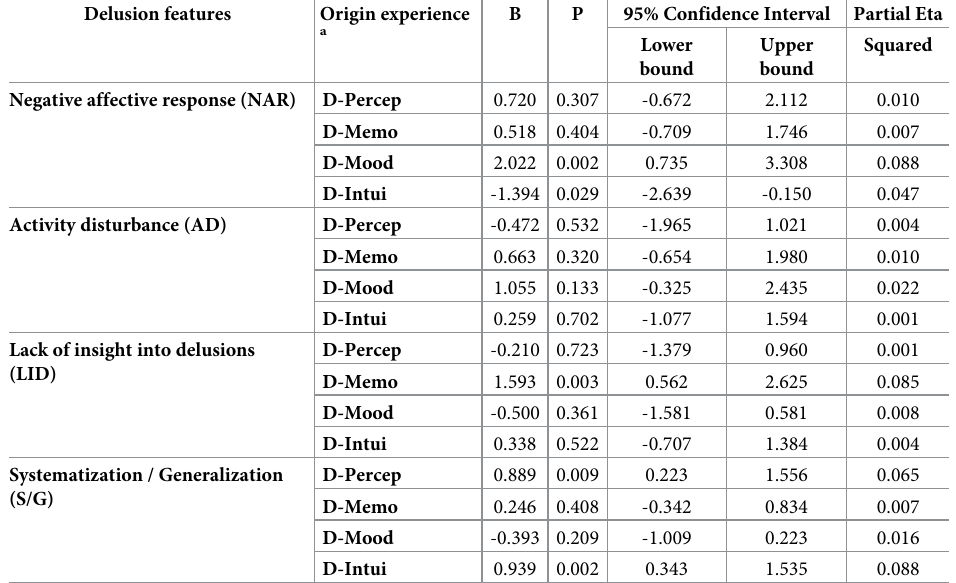
Table 6. Multivariate analyses of covariance (MANCOVA) regression of MOAI delusional features with primary delusions